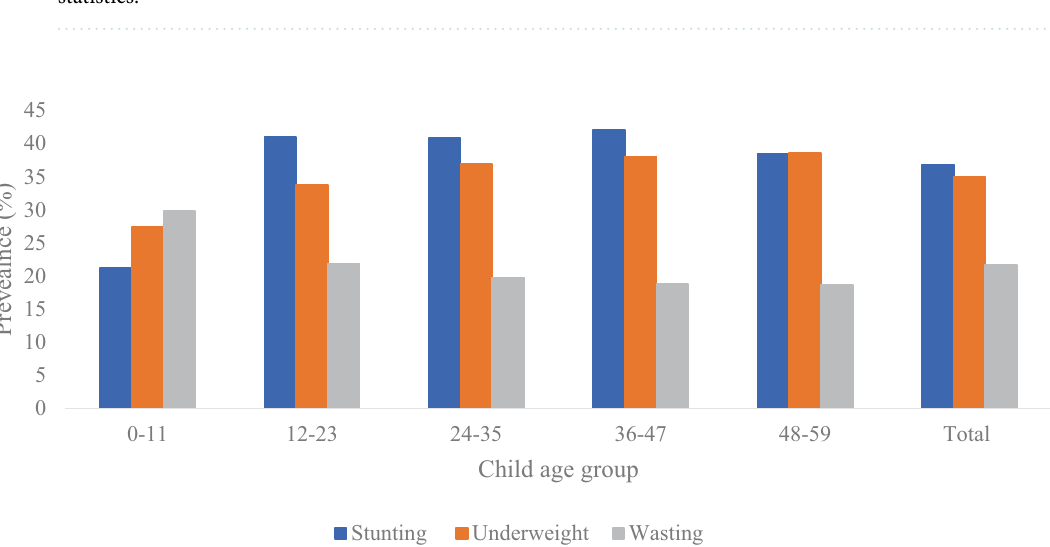
Table 3. Prevalence of different high-risk fertility behaviour by sociodemographic characteristics among children aged 0–59 months, India NFHS-4, p values present the level of significance of Pearson’s chi-square statistics.